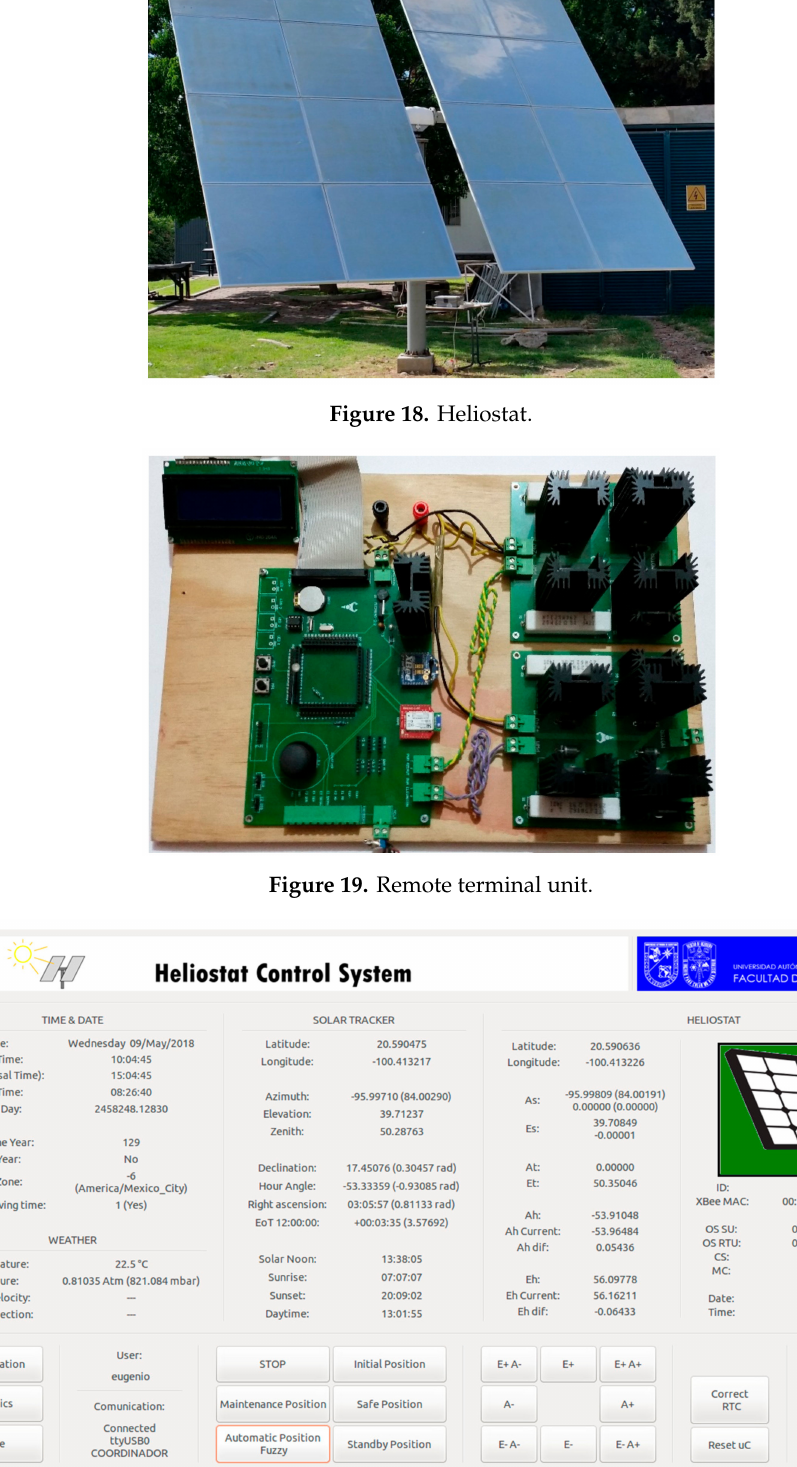
Figure 20. Graphical user